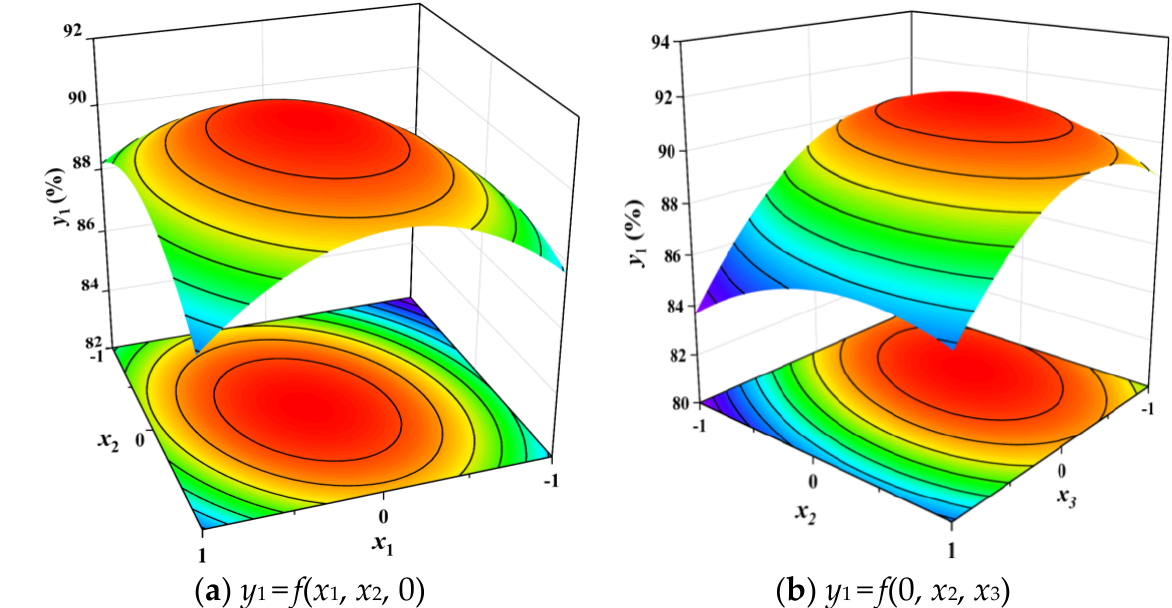
Figure 11. Effect of interaction between factors on SAR.